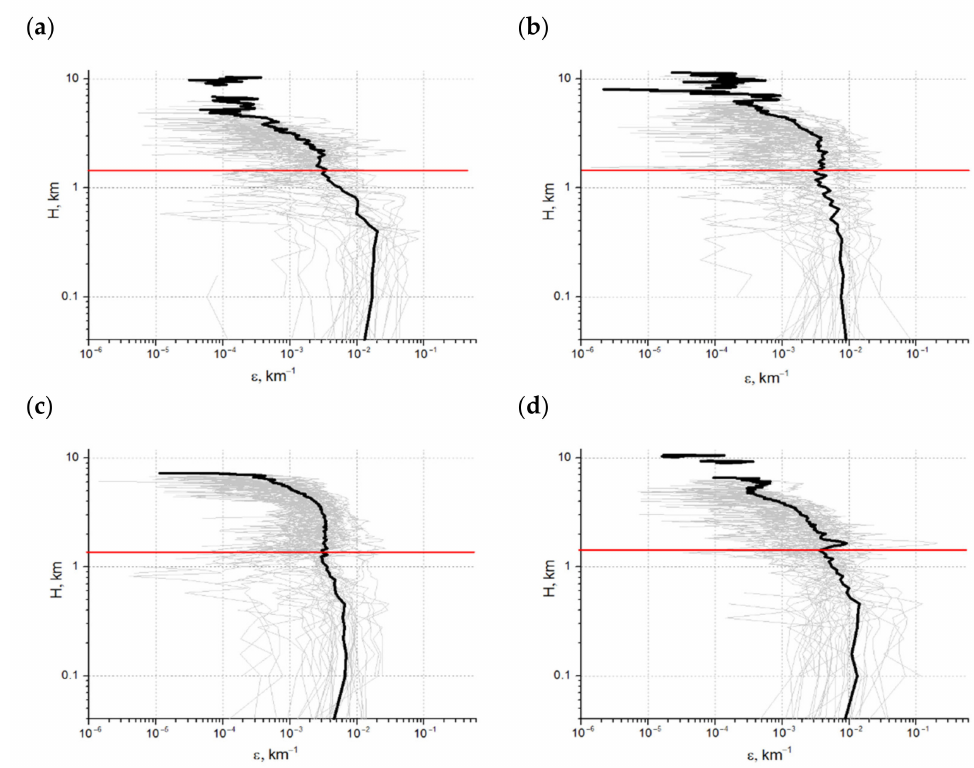
Figure 8. Monthly average (thin gray lines) vertical tropospheric aerosol extinction coefficient profiles according to CALIPSO satellite data in 2006–2021: ( a ) in winter (December–January–February); ( b ) in spring (March–April–May); ( c ) in summer (June–July–August); ( d ) in autumn (September–October– November). Bold black lines show the average seasonal profiles from 2006–2021. Mean surface elevation in the Urmia Lake region (of 1.5 km) is indicated with the red